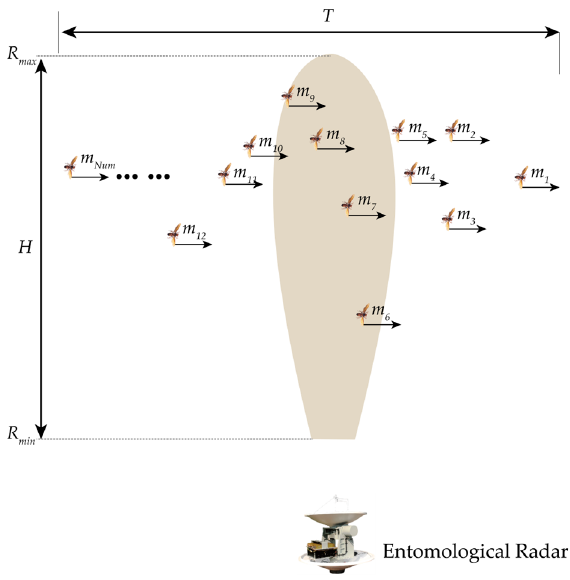
Figure 1. Schematic diagram of the migratory biomass. Equation (1) can also be equated with the product of the number of migrating insects and the average mass, i.e.,